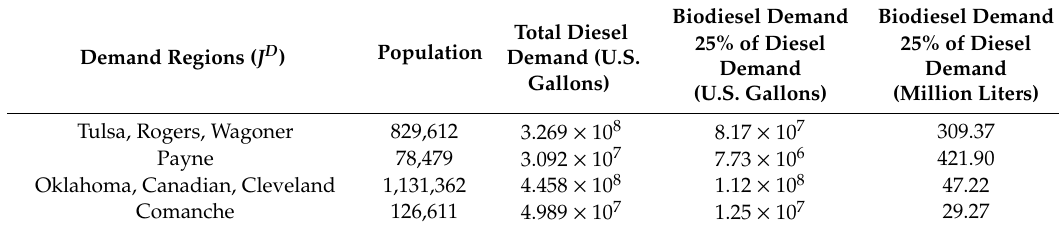
Figure 7. Demand counties, demand regions, and currently existing fuel terminals for the state of Oklahoma. Base map from U.S. Census Bureau [26]. Counties outlines in pink indicate those with a population density greater than 100 mi − 1 and are taken to be the demand centers. Blue squares indicate existing fuel terminals. Table 1. Population and diesel consumption for demand regions and for the entire state of Oklahoma, along with estimated biodiesel demand fulfillment